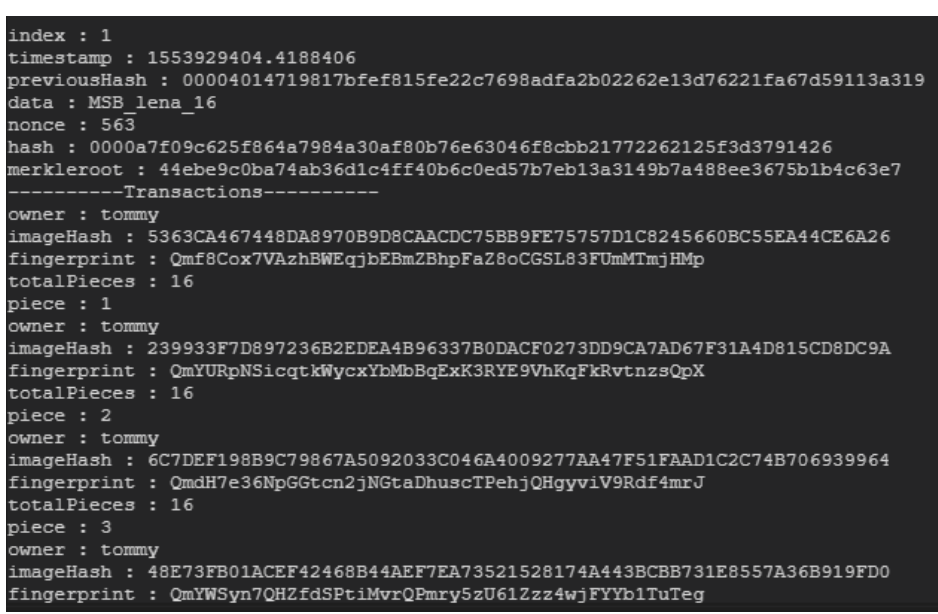
Figure 16. Stored transaction information to a block.